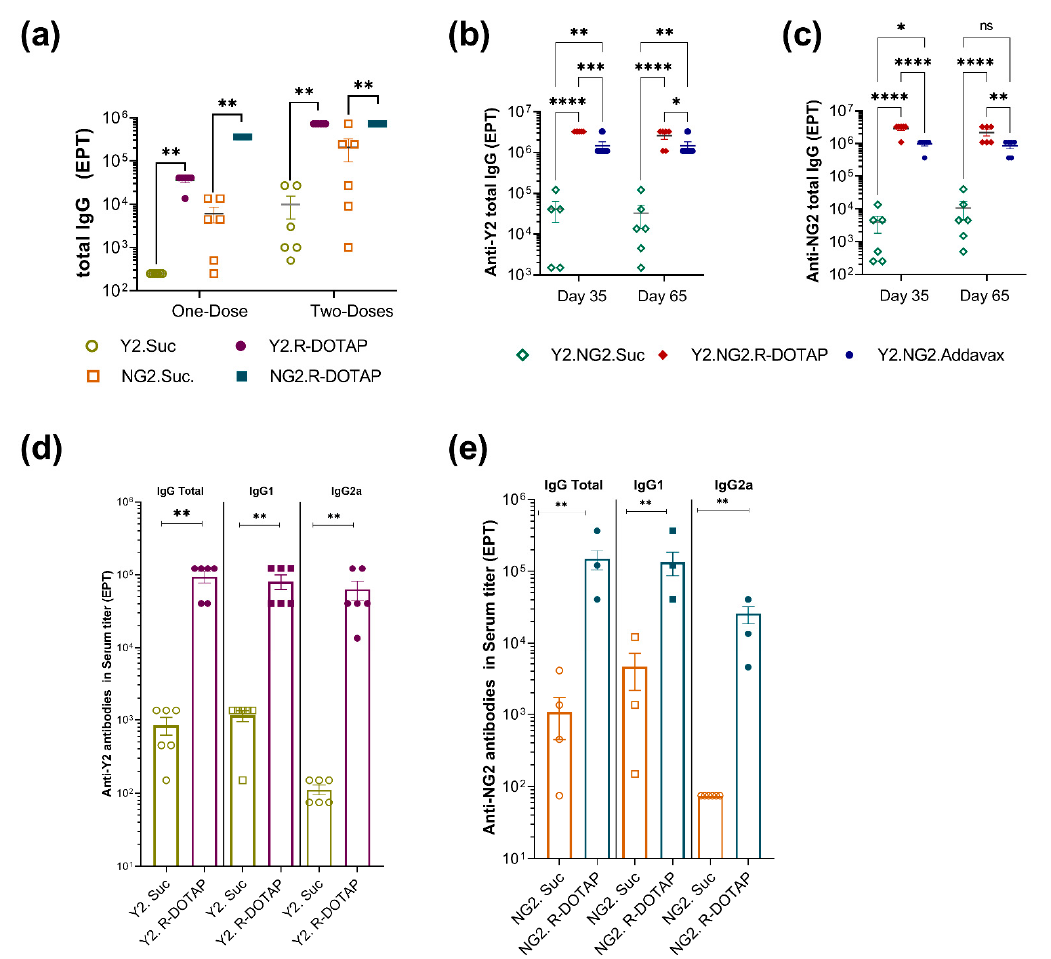
Figure 3. Antibody-mediated immune response induced by recombinant influenza protein formu- lated with R-DOTAP. Groups of BALB/cJ ( n = 6–8) mice were immunized intramuscularly on day 0 and day 21 with two doses of monovalent ( a ) COBRA-Y2 (H1) (3 µ g/dose), or COBRA NG2 (H3) (3 µ g/dose) or bivalent vaccines (R-DOTAP-Y2NG2) containing COBRA-NG2 (H3) (3 µ g/dose), and COBRA-Y2 (H1) (3 µ g/dose) ( b – e ), formulated with R-DOTAP nanoparticles, AddaVax or sucrose buffer (sucrose). ( a ) Serum samples obtained from vaccinated mice prior to second dose (one dose) on day 21 and 14 days after the second dose (two-doses) were measured for anti-COBRA-Y2 or Anti-COBRA-NG2 total IgG antibody titer by ELISA. Serum samples ( b , c ) obtained from vaccinated mice on day 35 (14 days after second dose) and day 65 (44 days after second dose) were measured for anti-COBRA-Y2, and anti-NG2 specific total IgG titers by ELISA. Serum samples ( d , e ) obtained from vaccinated mice on day 35 (14 days after the second dose) were measured for anti-Y2 and anti-NG2 total IgG, IgG1, and IgG2a antibody titer. Data represent ( a , d , e ) mean ± SEM end point titer (EPT) from each mouse. Data ( c , d ) represent reciprocal mean ± SEM of half-max titers from each mouse( a , b ) Comparisons between sucrose alone or R-DOTAP groups was performed using Student’s t -test (unpaired-two tailed). **** p ≤ 0.0001, *** p ≤ 0.0003, ** p ≤ 0.05, * p ≤ 0.01, ns p ≥ 0.1. Data shown are representative of three independent repeat